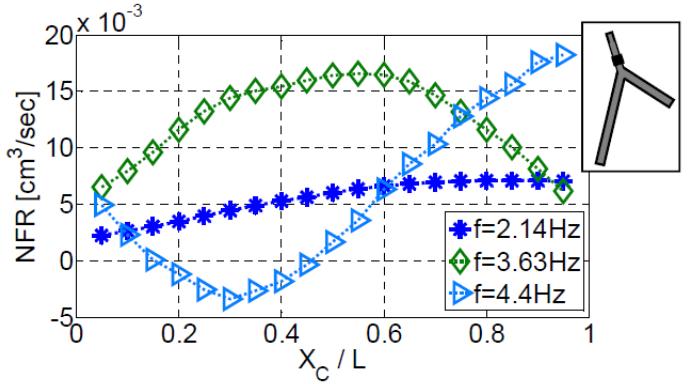
Figure 7. The dependence of NFR on the actuator location positioned on the first vessel of configuration III-b. Three actuation frequencies were examined.